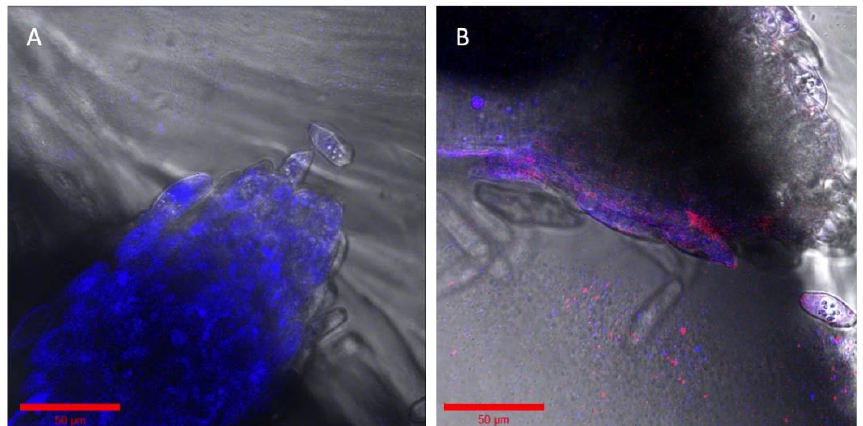
Figure 4. Succession of two similar engineered strains of Pseudomonas simiae . ( A ) The root was incubated with OD600 0.5 of P. simiae with mTagBFP in the imaging EcoFAB chamber for 3 days. ( B ) The same root is shown inoculated with mCherry – P. simiae after incubation for two days. Bar is 50 μm in both images. Colorized in Zen (Zeiss).